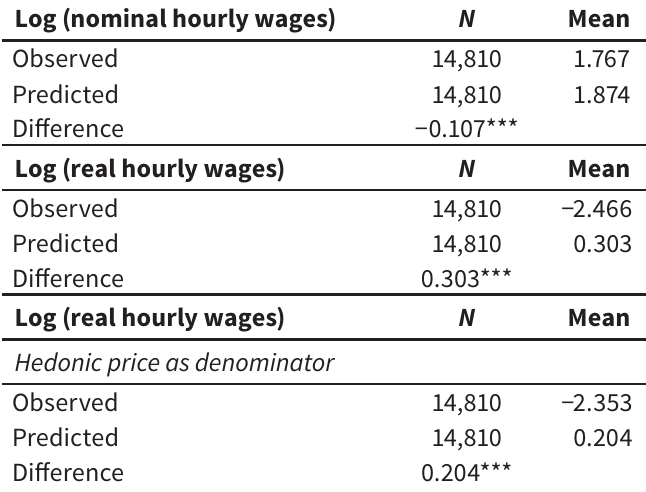
Differences of actual and predicted wages for metropolitan out-migrants, before